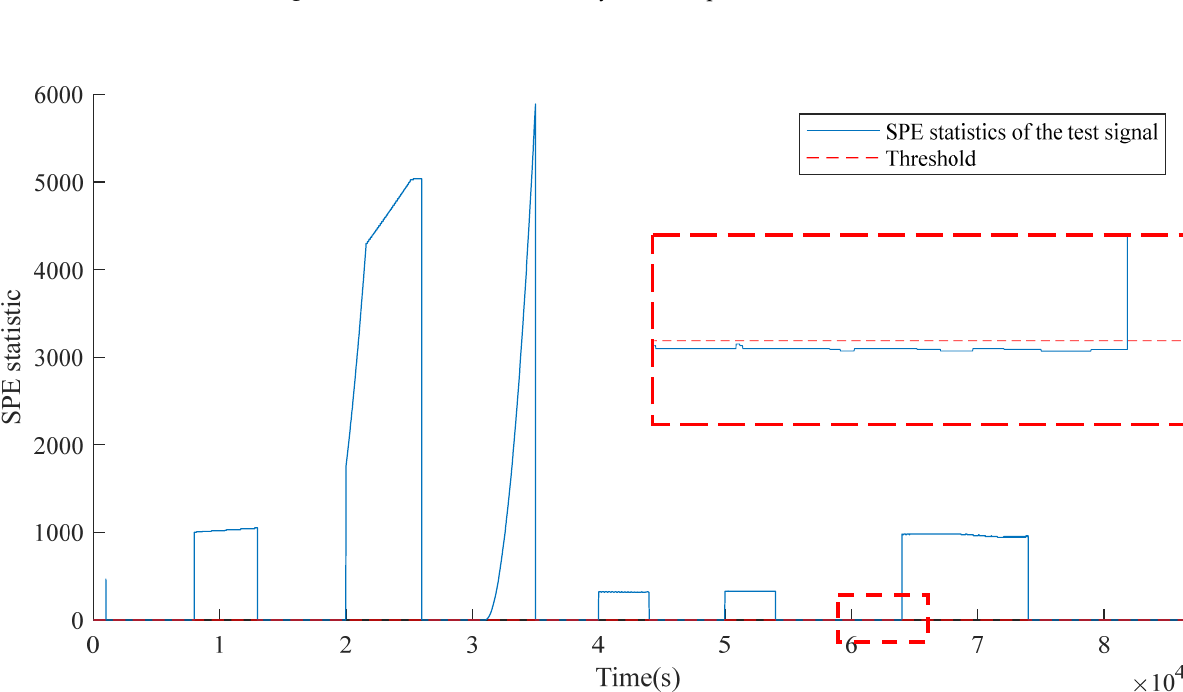
Figure 6. The SPE statistic troubleshooting results.